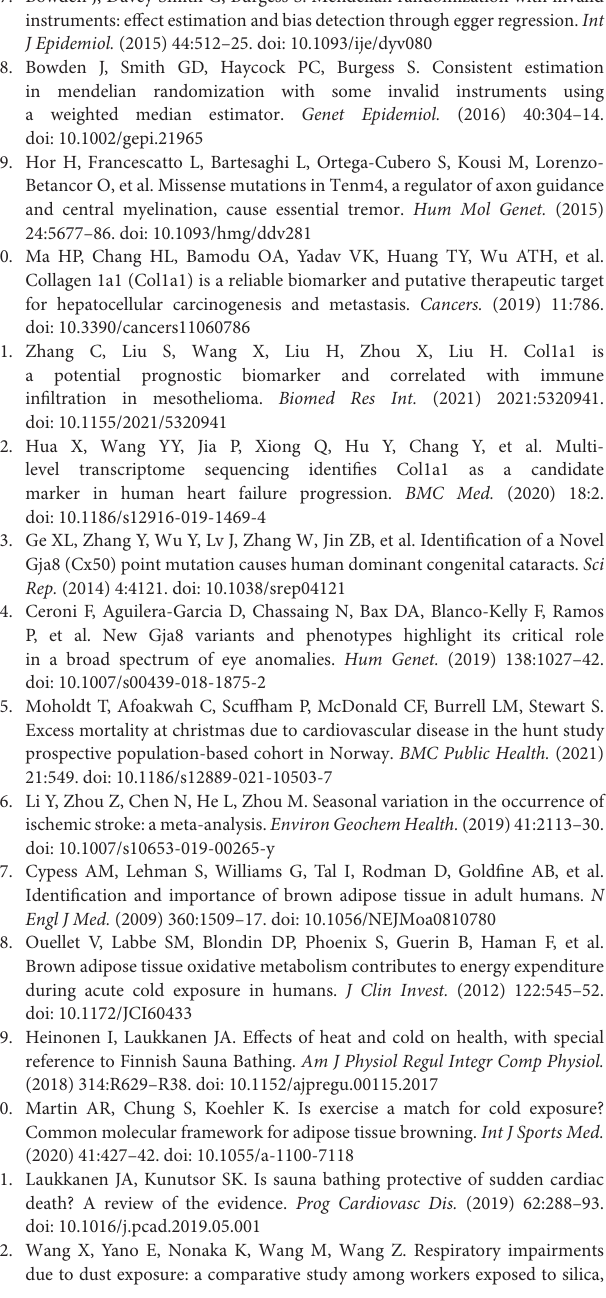
Supplementary Table 1 | Number of plasma proteins showed association with workplace environments in preliminary Mendelian randomization (MR) analysis via inverse variance weighted (IVW) approach. Supplementary Data 1 | GWAS datasets used for MR analysis in this study. Supplementary Data 2 | MR results between workplace environments and plasma proteins. Supplementary Data 3 | MR results between plasma proteins and disease